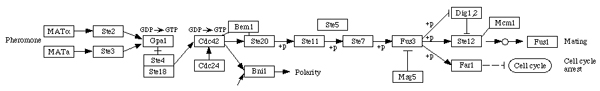
Yeast Pheromone Response Pathway. The yeast pheromone response pathway. This figure is from the KEGG [25] database.